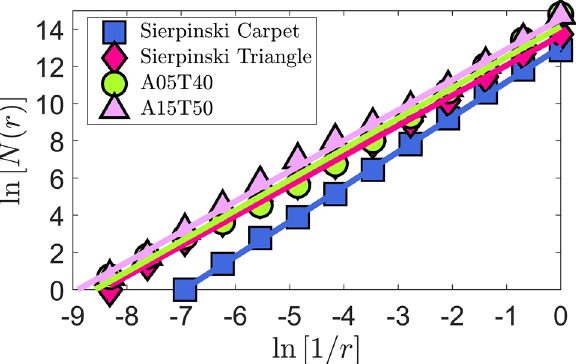
Figure 10. Linear fit obtained from the present box-counting 72,73 algorithm to determine the fractal dimensions for the Sierpinski triangle and Sierpinski carpet 73 compared to sample spray cases A 05 T 40 and A 15 T